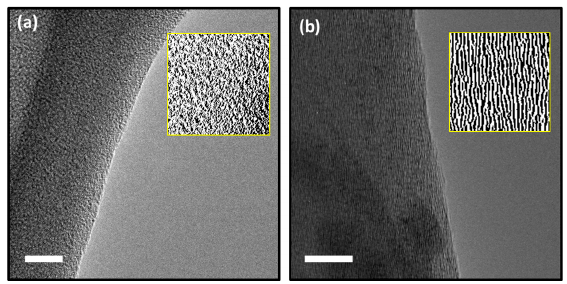
Figure 3. Transmission Electron Microscopy (TEM) images of carbon obtained from ( a ) Mechanically Treated CNF and ( b ) pure PAN with processed image in inset. The scale shown is 10 nm.